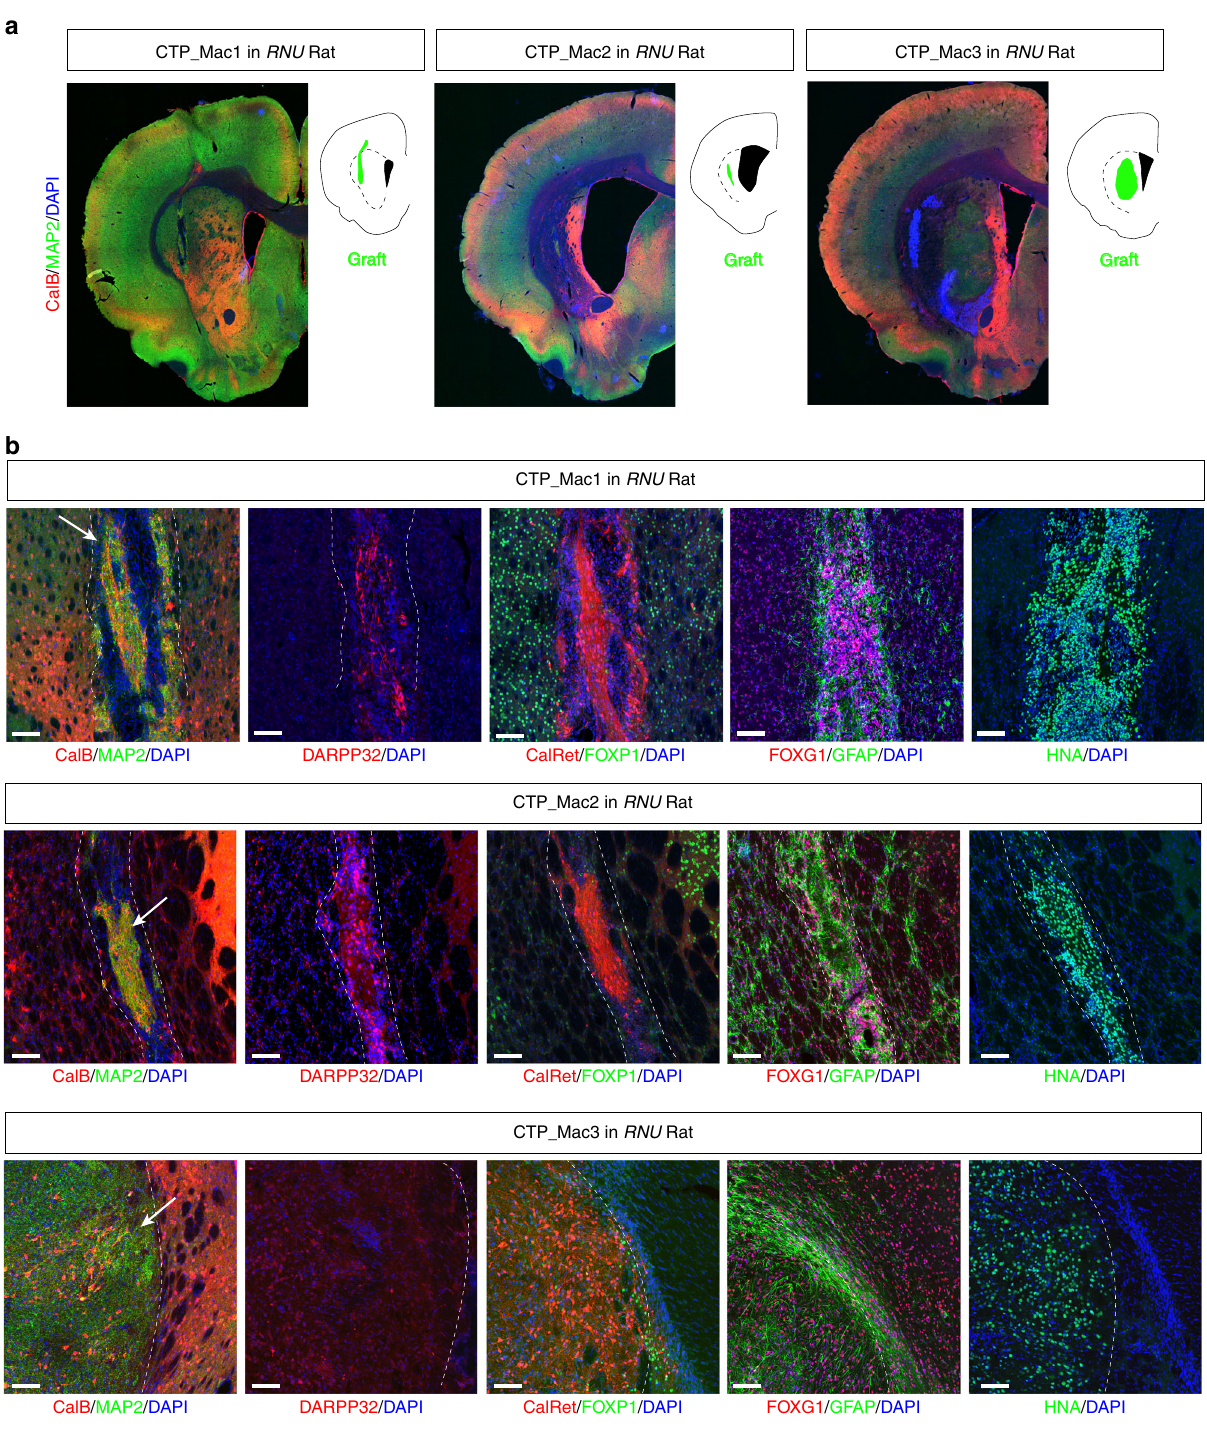
Fig. 2 In vivo characterization of CTP batches derived from NHP iPSCs in quinolinic acid-lesioned nude rats (RNU). a Representative coronal slices showing the localization of the graft in the striatum and immunostaining with striatal markers at 10 weeks post-grafting (Calbindin, CalB; MAP2). b Immunohistochemistry results illustrating the composition of the graft (white dotted lines, white arrow) using striatal medium spiny neurons markers (CalB, DARPP32, FOXP1), striatal interneurons marker (Calretinin: CalRet), human and NHP cell nuclear marker (HNA) and the astrocyte marker GFAP. Scale bar: 200 µ II (revealed by anti-HLA-DR monoclonal antibodies), CD68, grafts elicited little to no additional activation of these in fi ltrating CD45, CD8 and CD4 (Fig. 6 and Supplementary Figs. 4 – 6). Non- immune cells. In contrast, MI recipients presented a considerable transplanted QA-lesioned controls presented an activation of in fi ltration and marked staining for Iba1, MHC-class II, CD68, macrophages (CD68 + ) and little to no activation of in fi ltrating CD8, and CD4 around the graft and cavities (Fig. 6 and Sup- immune cells (CD45 + , CD8 + , CD4 + ) 17 . In this context, AU plementary Fig. 6b). These fi ndings suggest an ongoing rejection